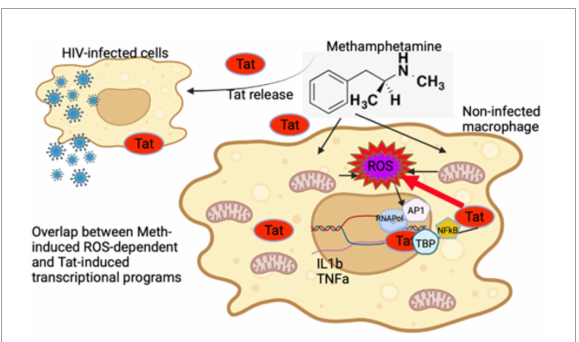
FIGURE13 Early events in innate immune cells resulting from interactions between Methamphetamine and HIV Tat. Tat released from HIV infected cells can modify transcription of non-infected cells and enhance the effects of stimulant substances such as Meth. Meth affects gene transcription immediately largely via ROS. While Tat further increases ROS-production by suppressing antioxidant genes upregulated by Meth, it does not potentiate the effects of ROS, represented by induction of IL1 β and TNF α genes via the activation of AP1 complex. The effects of Tat may bypass and add upon the effects of ROS induced by Meth, by activating other transcription factors, such as TBP and NFkB. As a result, an enhanced pro-inflammatory profile, resulting from a combination of ROS-dependent and -independent transcriptional factors, contribute to the pathogenesis of HIV in the context of Meth